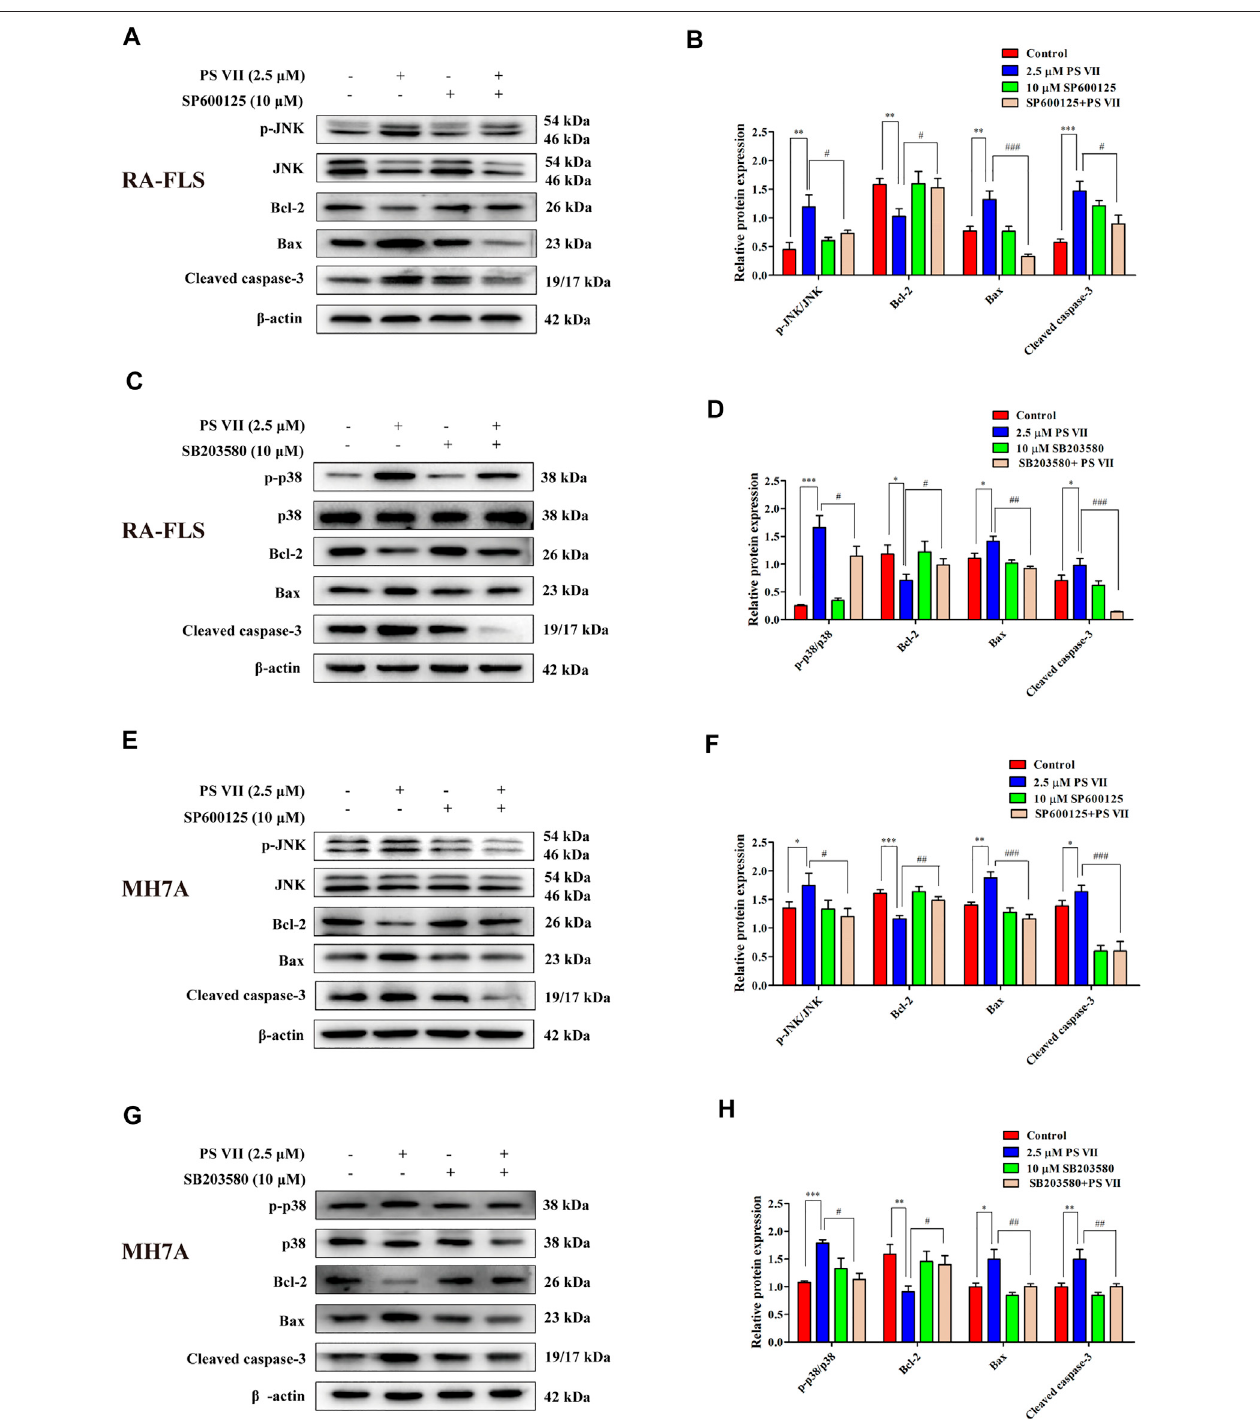
FIGURE 8 | Effects of PS VII and inhibitors of JNK (SP6001256), p38 (SB203580) on apoptosis-related proteins of RA-FLS and MH7A cells. The expression of p -JNK, JNK, p-p38, p38, Bax, Bcl-2, and Cleaved caspase-3 in RA-FLS (A, C) and MH7A cells (E, G) was determined by western blot analysis. Relative protein expression in RA-FLS (B, D) and MH7A cells (F, H) was determined by optical density analysis. Image J was used to determine the density ratio of the p -JNK, p-p38 band relative to total protein content in RA-FLS and MH7A cells, and the density ratio of the Bcl-2, Bax, and Cleaved caspase-3 bands relative to β -actin bands. Compared with the control group, * p < 0.05, ** p < 0.01, *** p < 0.001. Compared with the PS VII group, # p < 0.05, ## p < 0.01, ### p < 0.001.